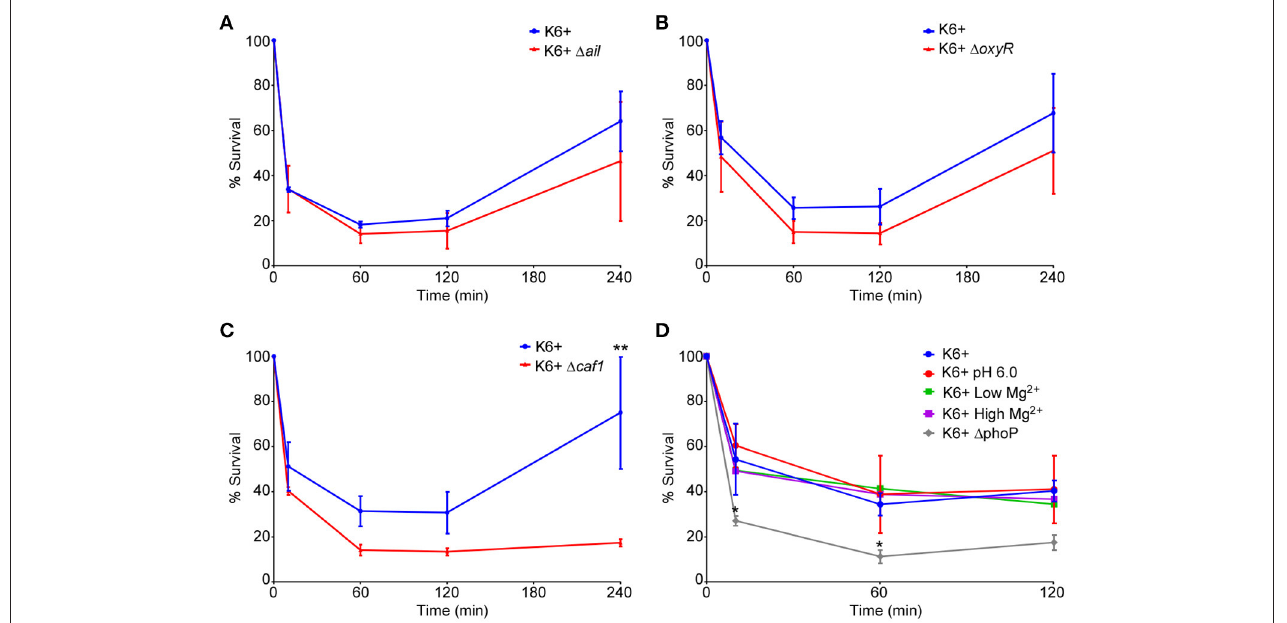
FIGURE 2 | Deletion of ail , oxyR , caf1 , or pre-induction of PhoPQ do not affect survival of Y. pestis within neutrophils. Human neutrophils were infected with KIM6 + or the different deletion mutants or PhoPQ pre-induced bacteria. Cells were lysed, triturated and plated to enumerate CFU at 10, 60, 120, and 240min post-infection. CFU data are shown as a percentage of the inoculum remaining in each well at the given time point. Each graph represents a separate set of experiments where the mutant/pre-induced strains were assayed side-by-side on the same day with cells from the same donors with the wt KIM6 + pH7.2. The deletion mutants (A) KIM6 + 1 ail , (B) KIM6 + 1 oxyR , and (C) KIM6 + 1 caf1 were compared to the parental strain. (D) KIM6 + grown at pH6.0 or with low Mg 2 + (128 µ M) to pre-induce PhoPQ expression were compared to the same strain grown at pH7.2 or in Mg 2 + -replete medium (High Mg 2 + , 1,000 µ M). A KIM6 + 1 phoP mutant strain was included for comparison. Each graph represents the mean of 3 independent experiments. Day-to-day and donor-to-donor variation necessitated running separate wt KIM6 + controls alongside each deletion mutant or growth condition tested. Error bars represent SEM. Statistical differences were determined by multiple T -tests comparing 2 groups at each time point, corrected for multiple comparisons using Holm-Sidak method. * p < 0.05, ** p <